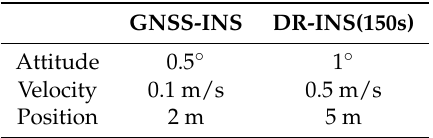
Table 2. Navigation system experimental data